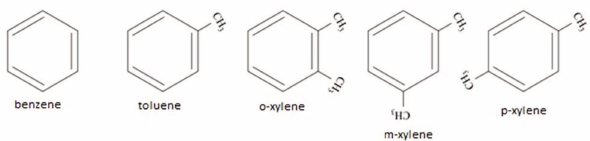
Fig. 2. Skeletal formulas of aromatic hydrocarbons molecules belonging to BTX